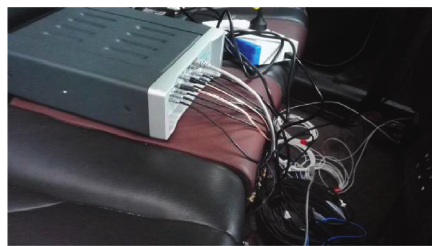
Figure 22: Digital acquisition hardware inside the car.